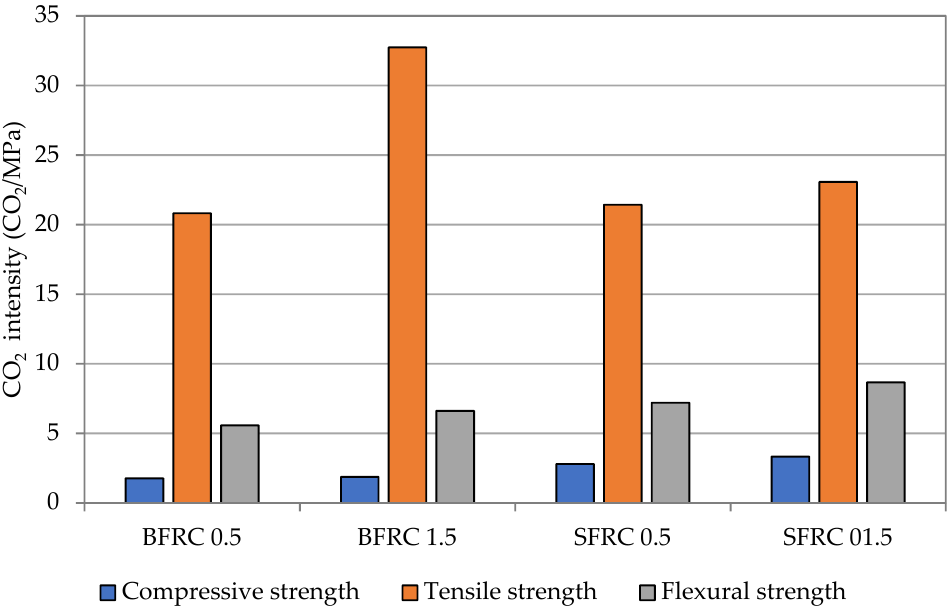
Figure 7. CO 2 intensity comparison of concrete reinforced by basalt and steel fibers.